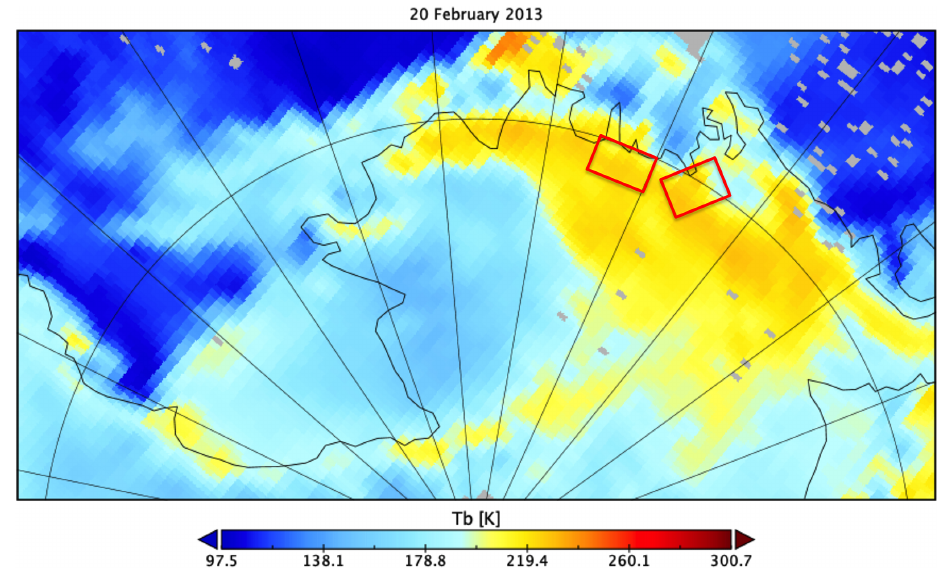
Figure B3. SSMIS horizontally polarized 19.35GHz brightness temperature over West Antarctica and the RIS on 20 February 2013, with red boxes denoting the Thwaites Glacier (left) and Pine Island Glacier (right) bounding regions.